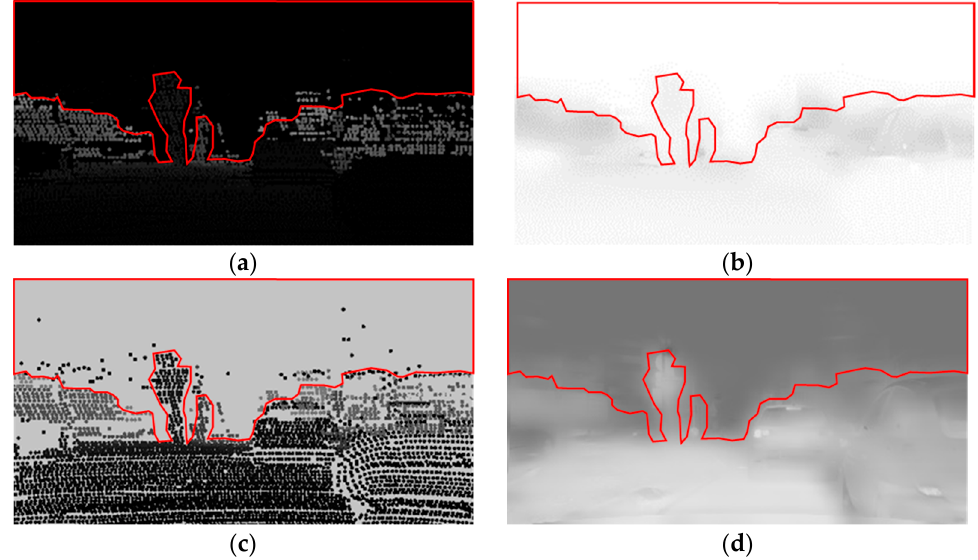
Figure 12. Comparison applying background parameter: ( a ) before applying; ( b ) transmission image